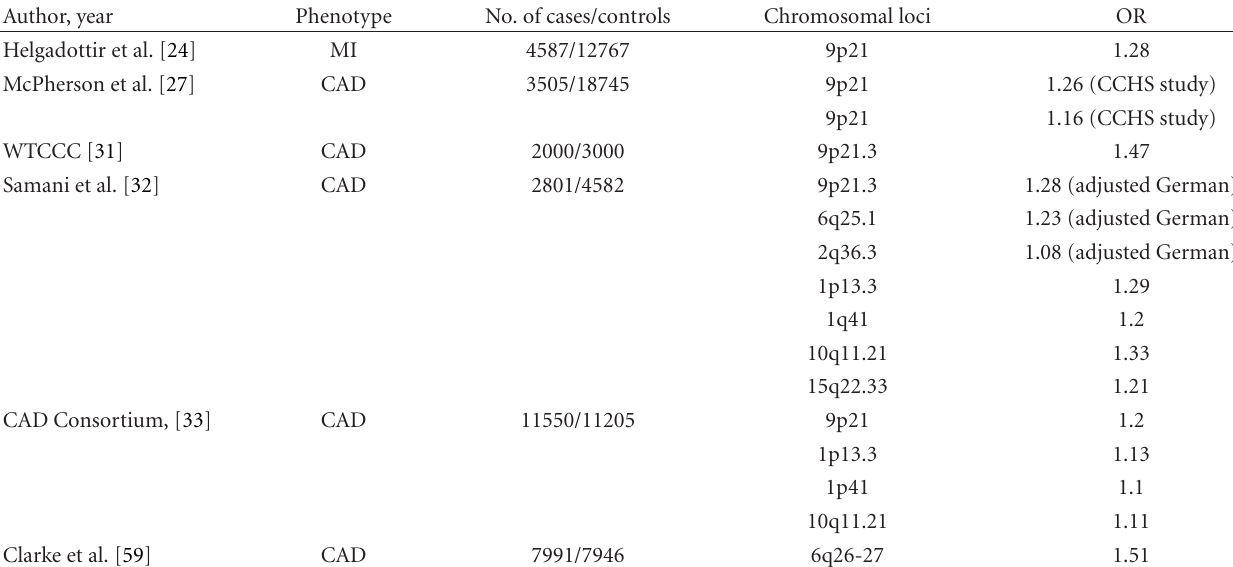
Table 3: Representatives of chip-based GWAS of CAD/MI.